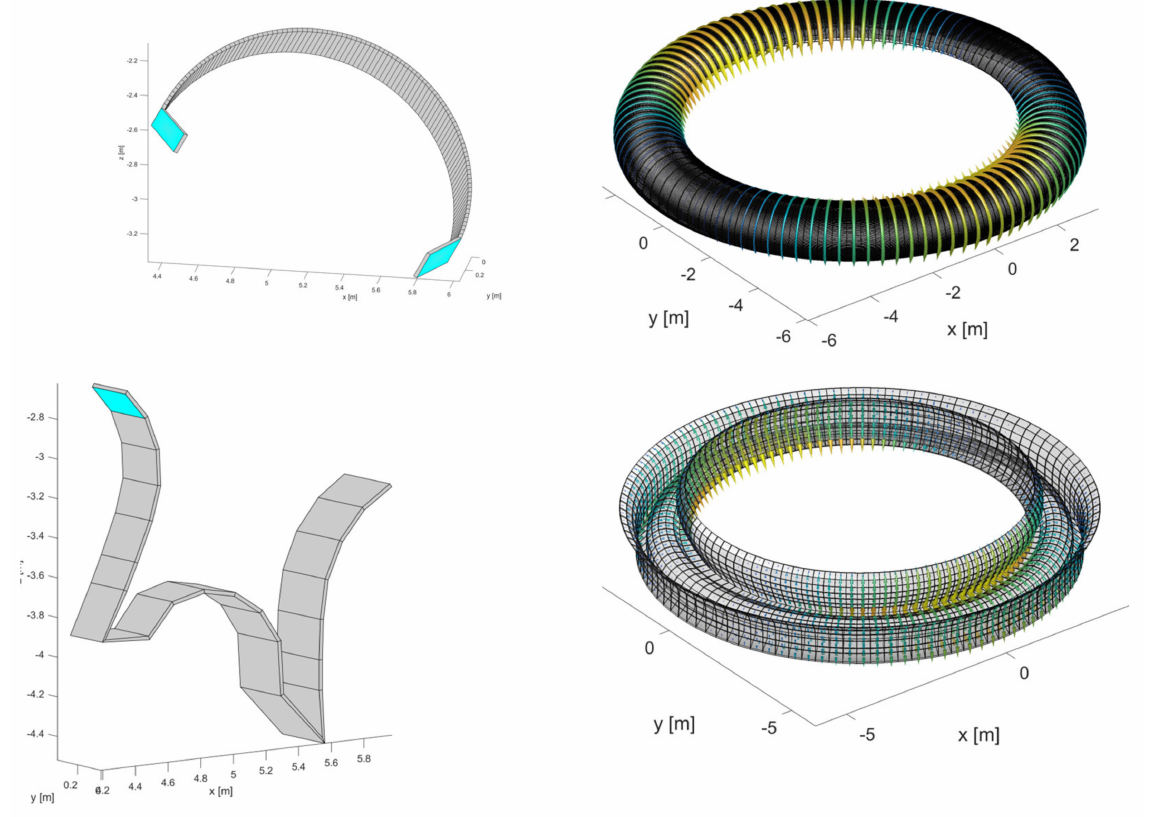
Figure 10. Two supplementary models of bridges for the anti-symmetric halo current component intended for comparing of errors caused by different simplifying assumptions, both featuring not helical but still poloidal bridges, both with fixed location of halo current injection belts. In Model #3 (upper row), poloidal bridges wrap around plasma. In Model #4 (bottom row), poloidal bridges are located close to the wall. Color code represents not direction but modulus of the current density when models are fed by anti-symmetric halo